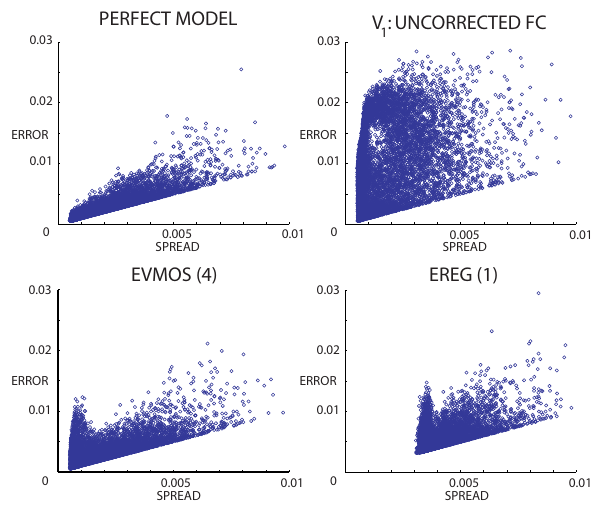
Fig. 11. Scatterplot of spread against error of 10000 ensembles at t = 0 . 2. The spread is the square root of the ensemble variance and the error is the ensemble average of u r . The results are generated using the Lorenz model with large model error ( δr = 10 − 2 ) using ensembles of 500 members each. The perfect-model result is ob- tained without model error.